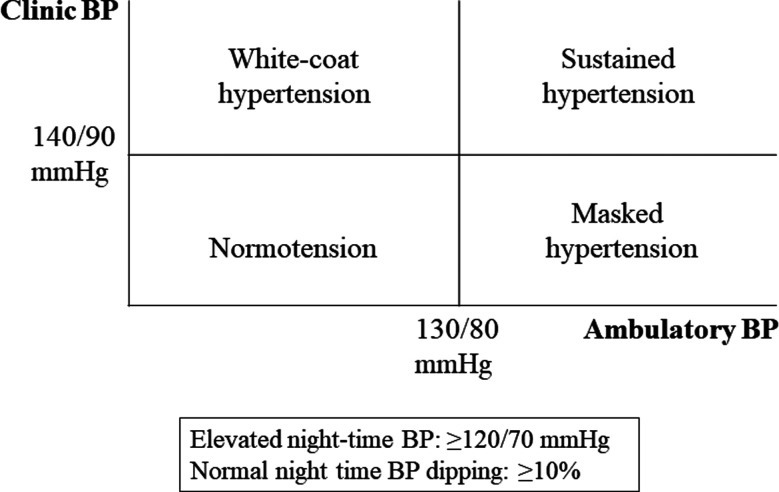
Classification of BB status according to office and ambulatory BP values. BP, blood pressure.